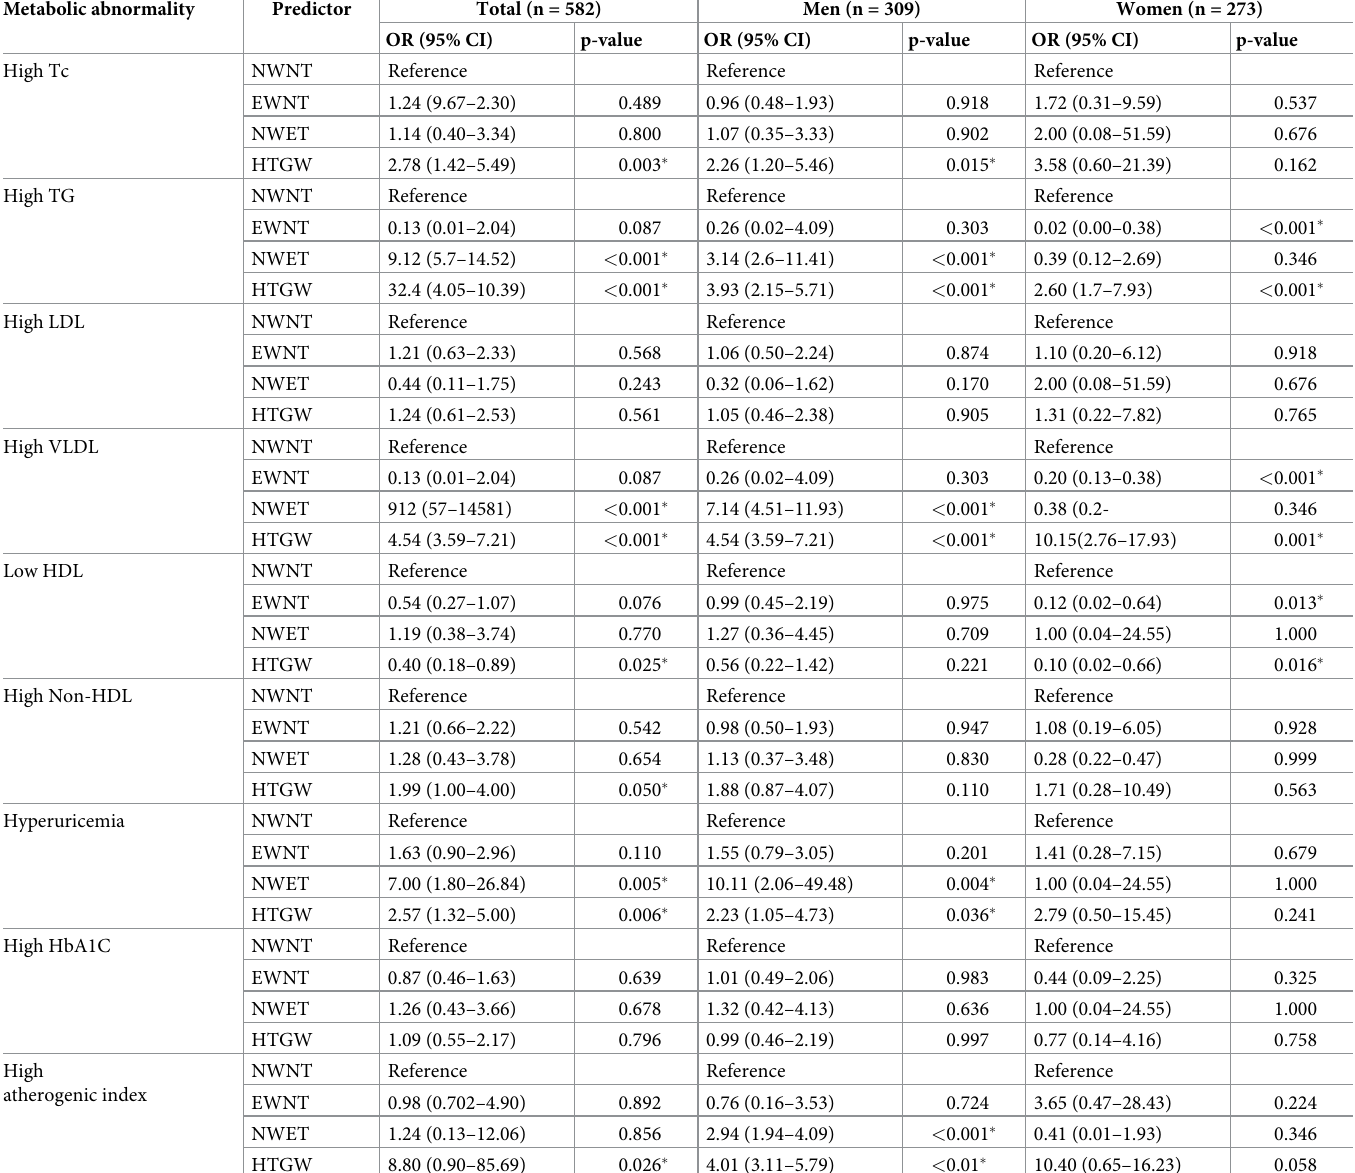
Table 4. Association of Triglyceridemic-waist phenotypes with metabolic abnormalities. Metabolic